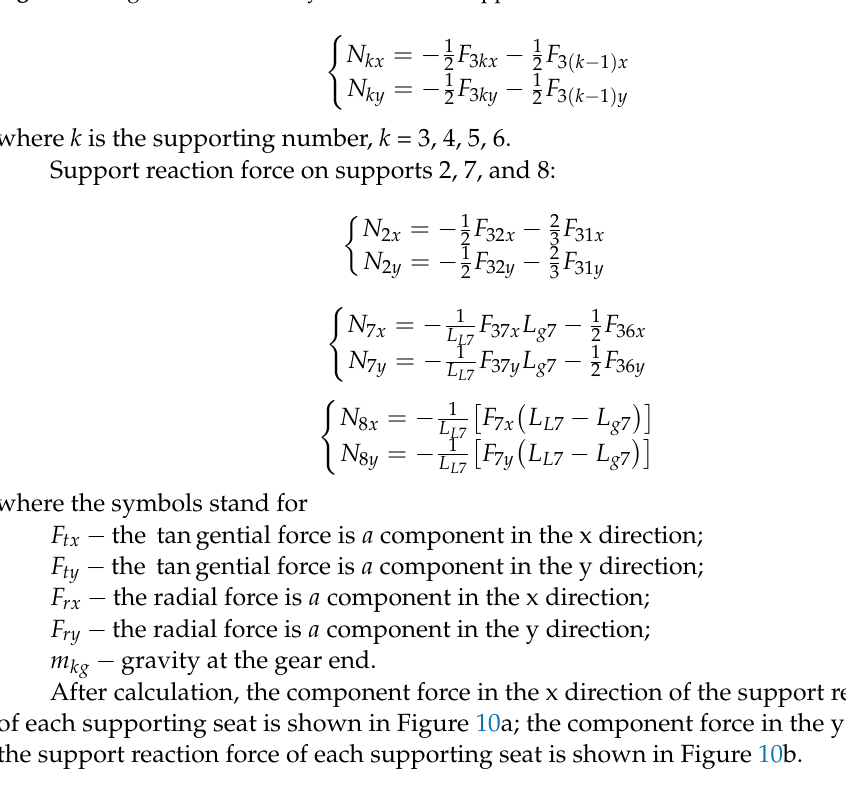
Figure 9. Diagram of force analysis on middle support 3 of the crankshaft.